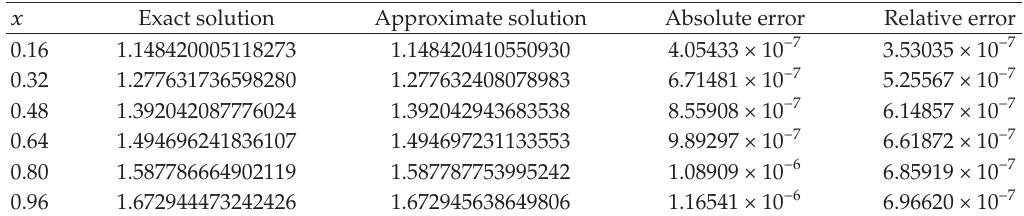
Table 6: Numerical results for Example